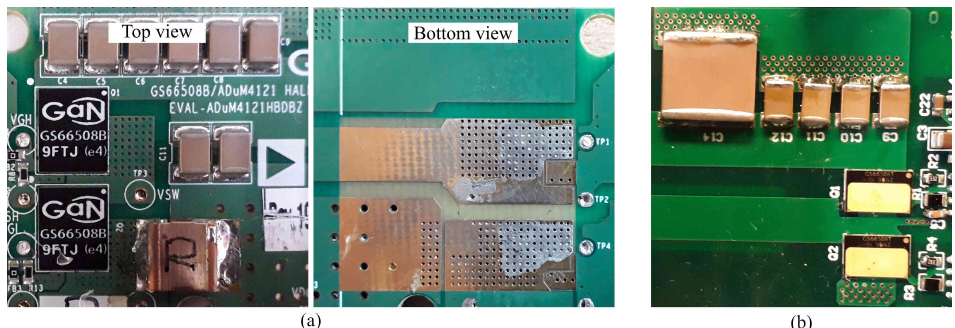
Figure 16. View of the GaN-based power converters: ( a ) bottom-side cooled converter; and ( b ) top-side cooled